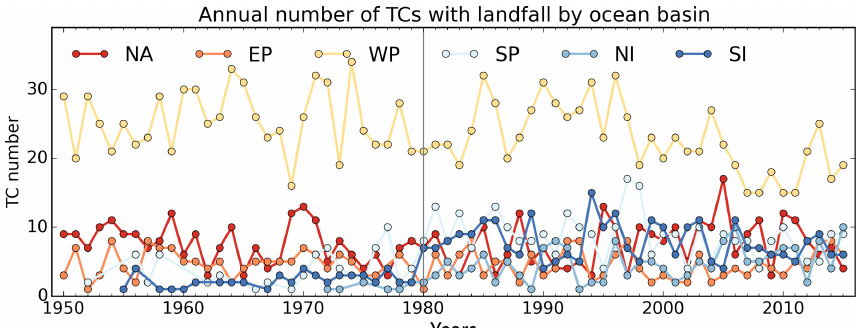
Figure 2. Annual numbers of TC landfalls by ocean basin. The number of TC landfalls varies greatly due to the stochastic occurrence of landfalls, natural variability, and reporting biases (prior to 1980, indicated by vertical gray line). Ocean basin abbreviations are as follows: NA, North Atlantic (red); EP, east Pacific (orange); WP, west Pacific (yellow); SP, South Pacific (light blue); NI, north Indian (blue); SI, south Indian (dark blue). South Atlantic is excluded (2